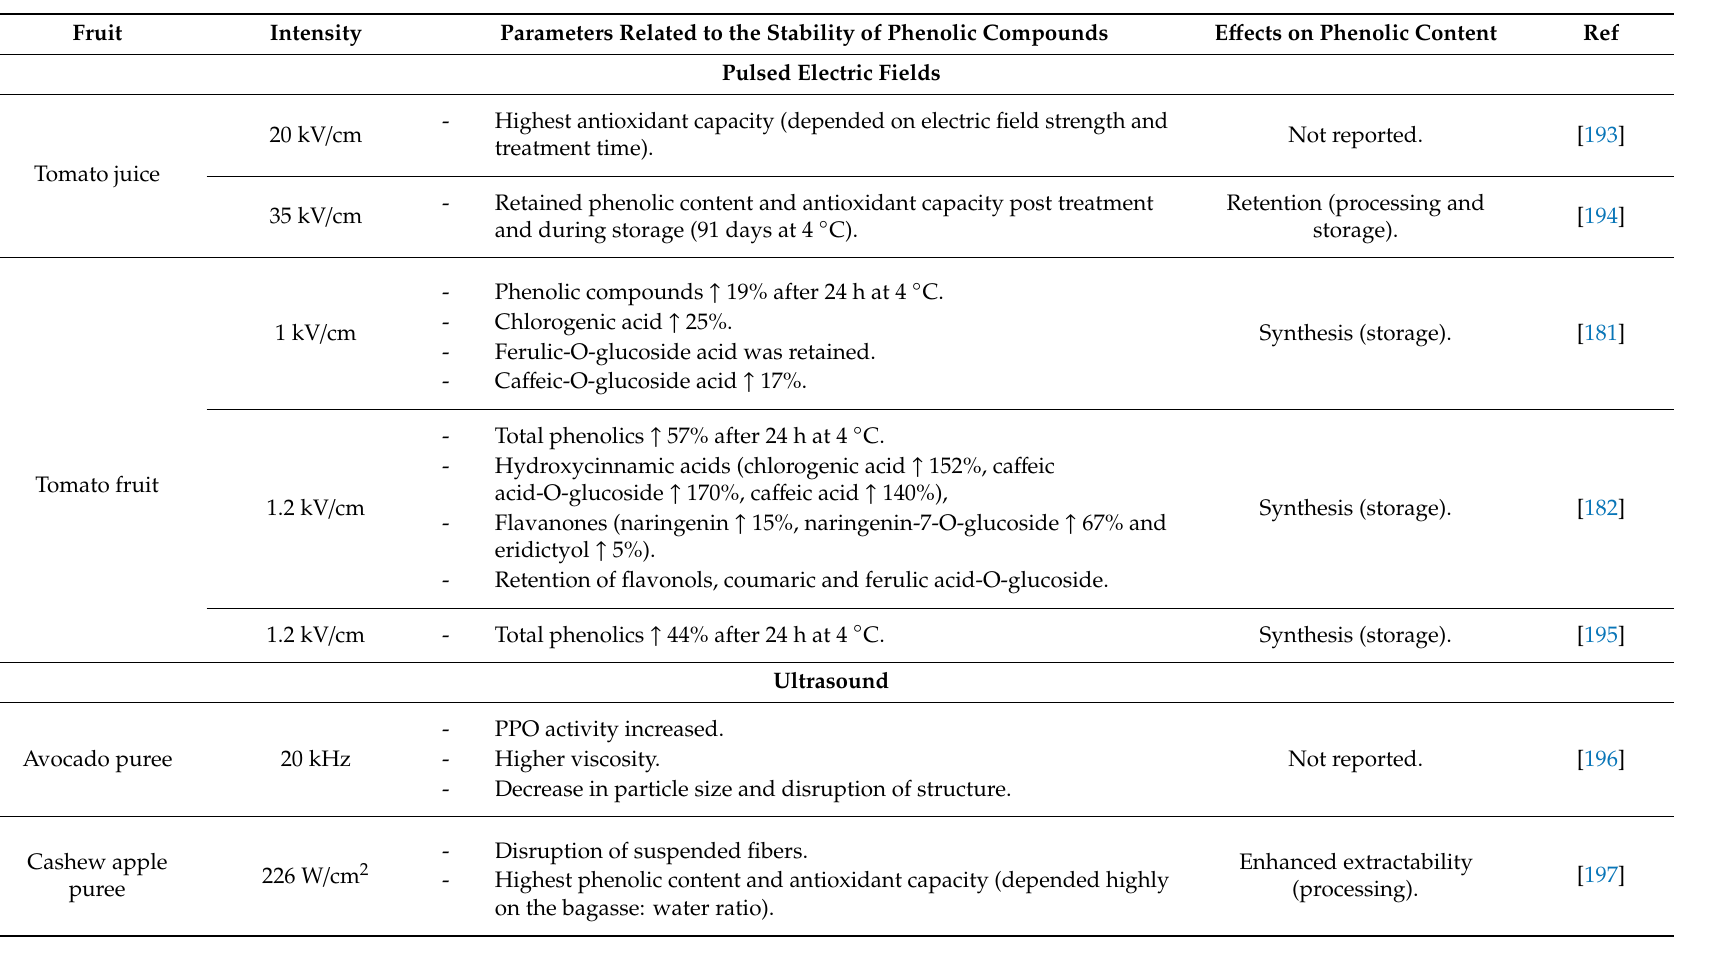
Table 6. E ff ects of other innovative technologies on phenolic compounds and parameters related to their stability in Mesoamerican fruits.